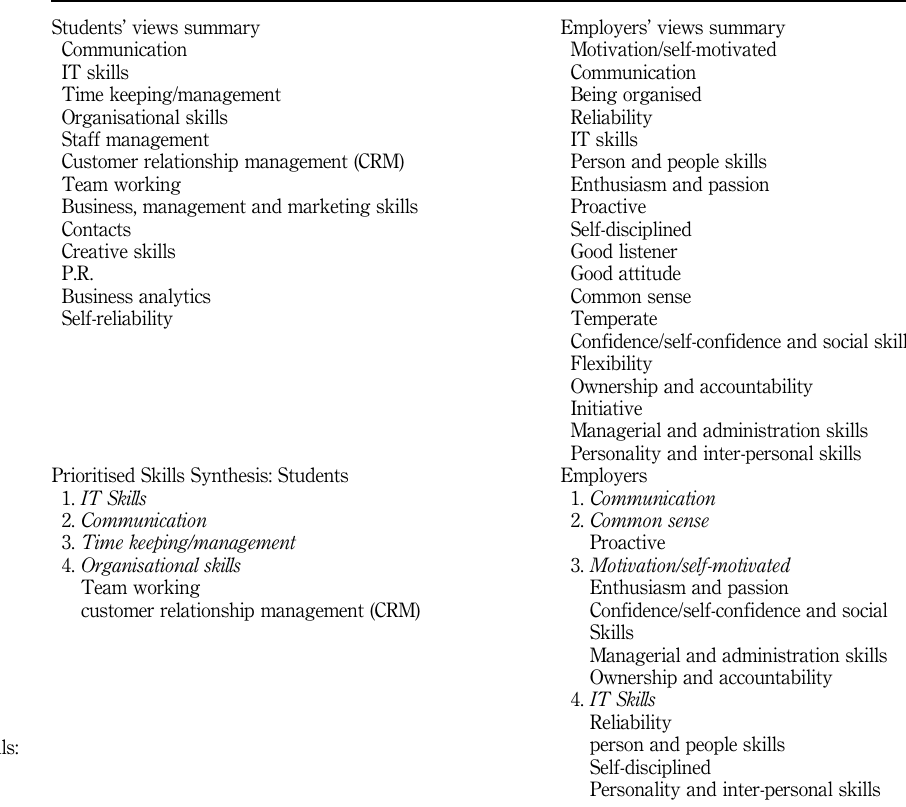
Table II. Employability skills: prioritised skills